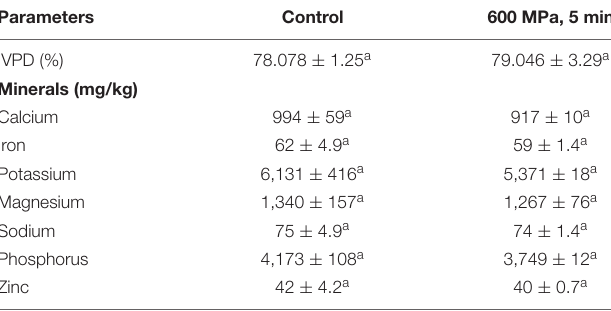
TABLE 3 | In vitro Protein digestibility and mineral content of the control and high pressure processed cooked chickpeas.